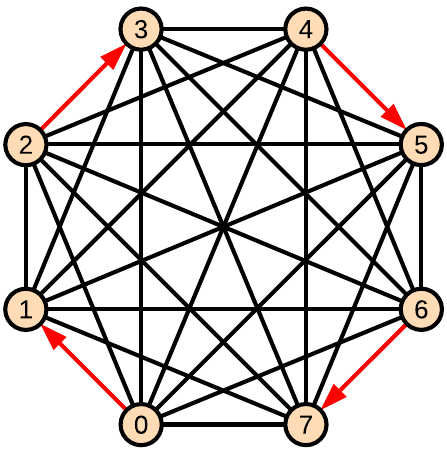
Figure 4. Complete mixed structure of four panels G 8